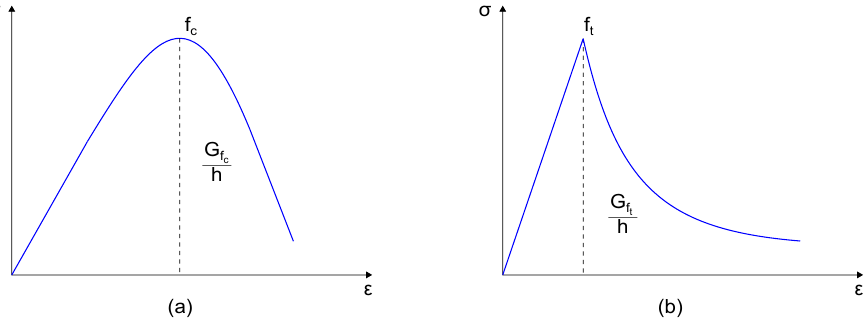
Figure 4. Mechanical behavior of brick elements and mortar layers: ( a ) stress–strain curve in com- pression; ( b ) stress–strain curve in